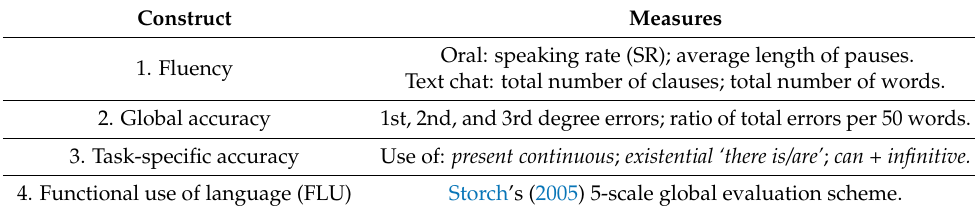
Table 1. Measures of fluency, global and task-specific accuracy, and functional language